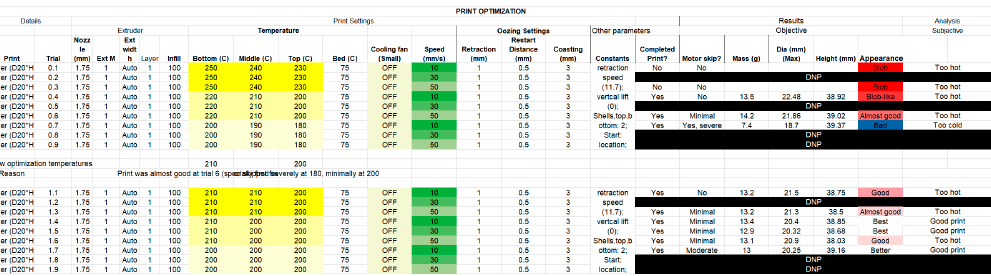
Figure A3. Print optimization with no-fan, small tall cylinder.